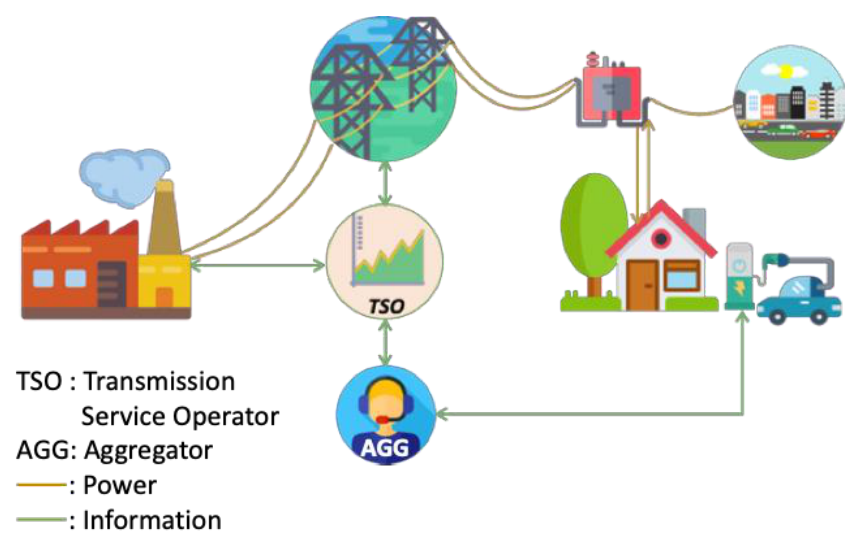
Figure 3. Vehicle-to-grid (V2G) with electric vehicles (EVs), bi-directional charger, and aggregator.